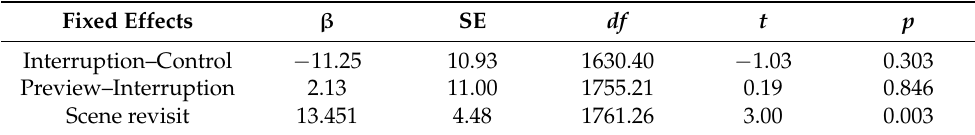
Table A2. Preregistered main analysis of search initiation time SIE.